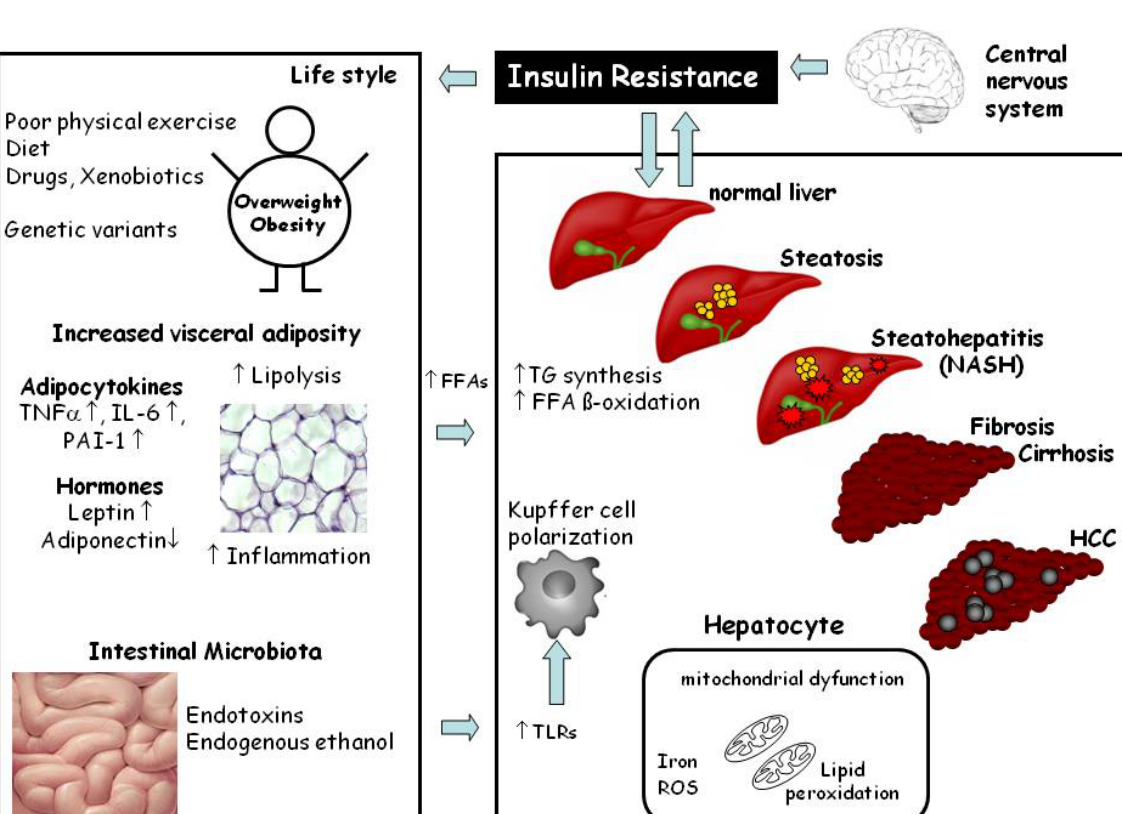
Figure 1. Schematic drawing of the molecular mechanisms involved in the development and progression of non-alcoholic fatty liver disease (NAFLD). The risk factors such as being overweight, visceral adiposity, adipocytokines may increase the flow of free fatty acids (FFAs) to the liver. Alterations of intestinal microbiota and increased permeation of bacterial endotoxins, from the gut may activate Toll-like receptor signaling cascades and lead to a M1 polarization of macrophages (e.g., of Kupffer cells and infiltrating macrophages). All these events (e.g., increased FFAs, adipocytokines, endotoxins, insulin resistance, macrophage polarization) may lead to the development of NAFLD. (Modified from Krawczyk et al.